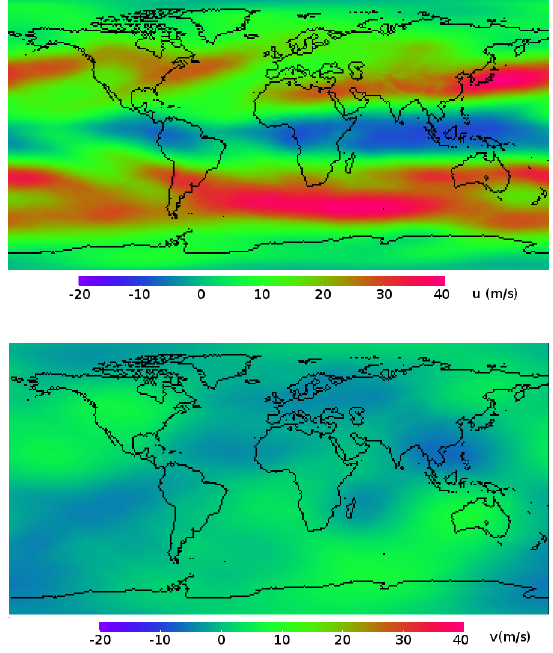
Fig. 5. Annual mean (2007) zonal (top) and meridional (bot- tom) components of the wind field at approximately 10 km height. Source: ECMWF (European Centre for Medium-Range Weather Forecasts).